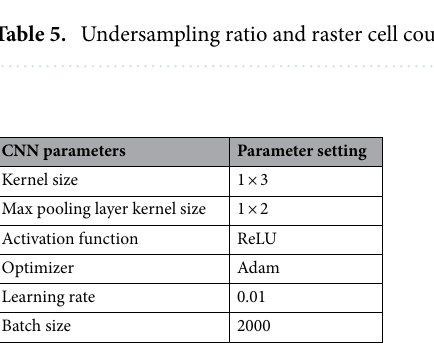
Table 6. Parameter setting of CNN